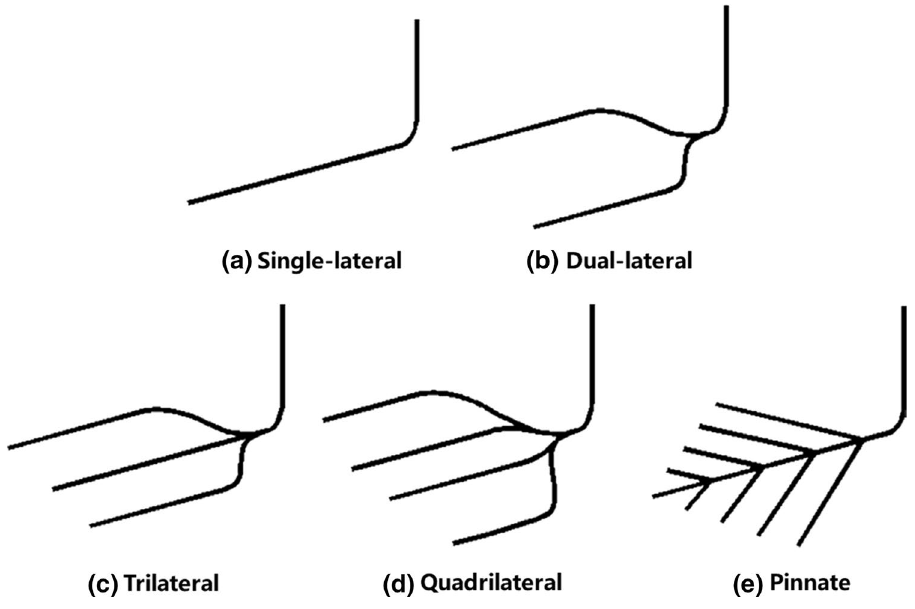
Fig. 11 Different patterns of multilateral well (Maricic et al. 2008)